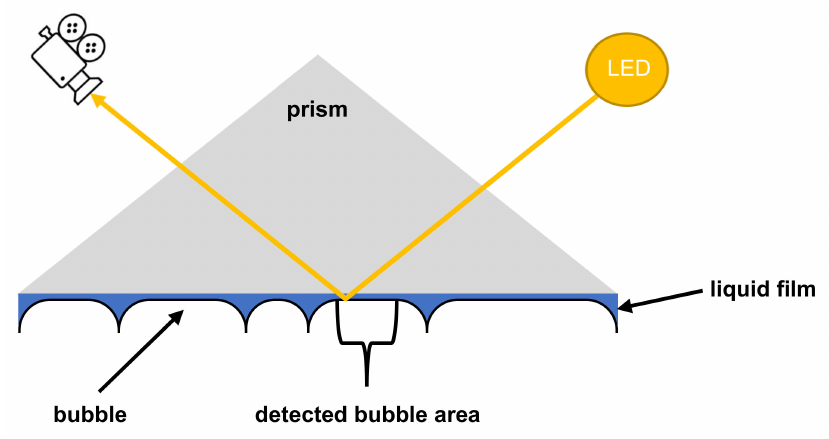
Figure 3. Scheme of the measuring principle of the structure detection applied by the